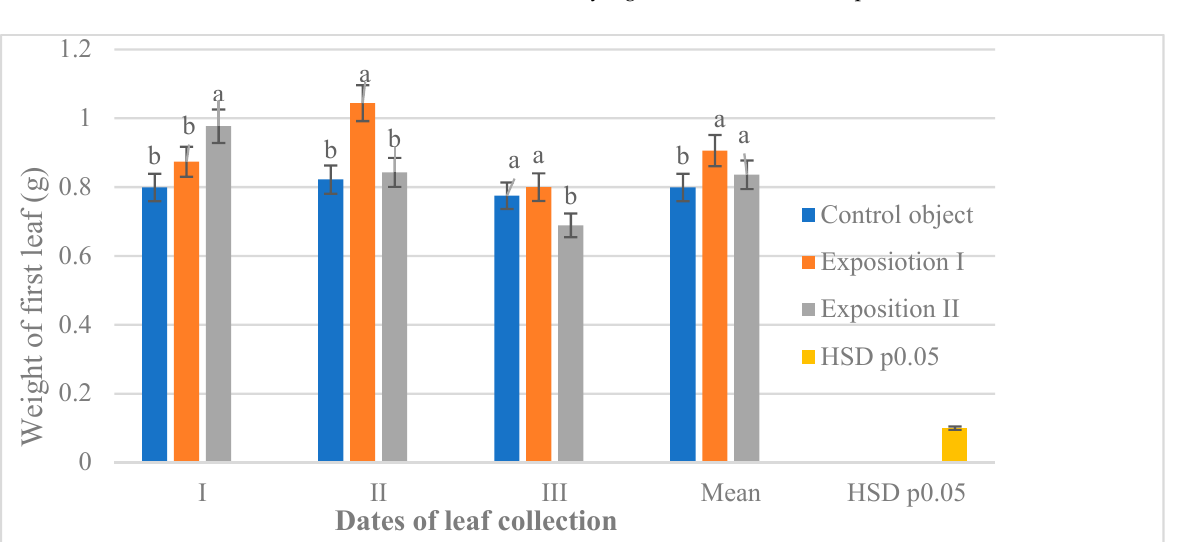
Figure 5. Effect of FM stimulation on germination energy, strength, and capacity of bean seeds (2015–2017 average). Control object—the seeds without stimulation with FM, exposition I—the seeds were stimulated with FM for 15 s, exposition II—the seeds were stimulated with FM for 30 s. Letter indicators (a, b, c, etc.) next to averages refer to the so-called homogeneous (statistically homogeneous) groups. The occurrence of the same letter indicator next to the means (at least one) means that there are no statistically significant differences at p 0.05 between them.